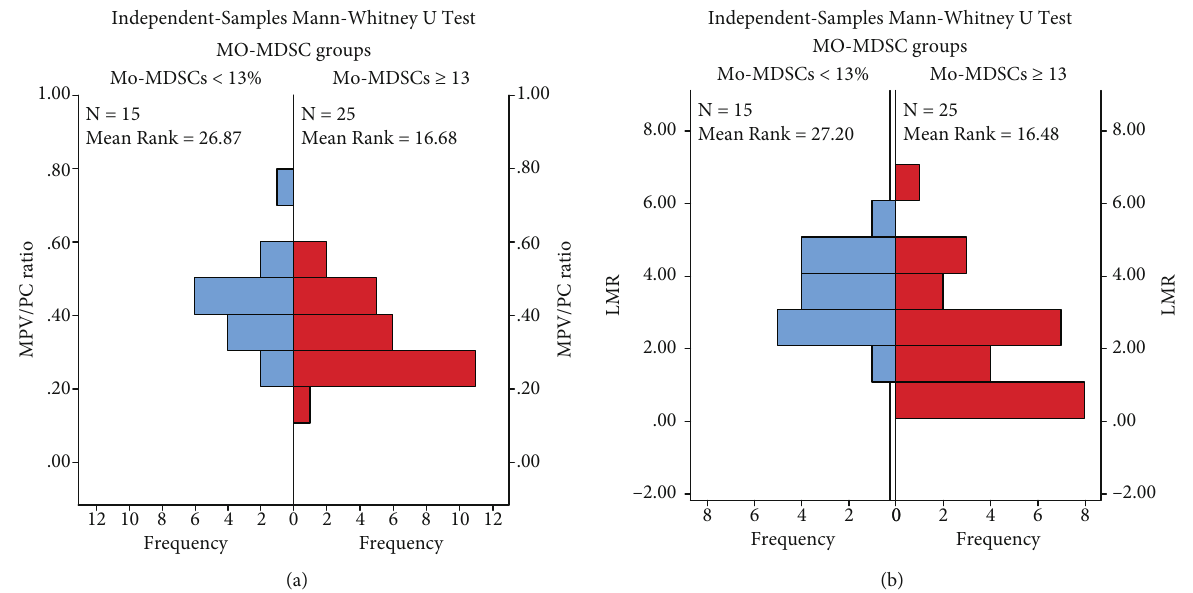
Figure 6: (a) Di ff erences of MPV/PC according to cuto ff point values of Mo-MDSCs. (b) Di ff erences of LMR according to cuto ff point values of Mo-MDSCs. Table 6: Multiple linear regression test of di ff erent predictors of OS.